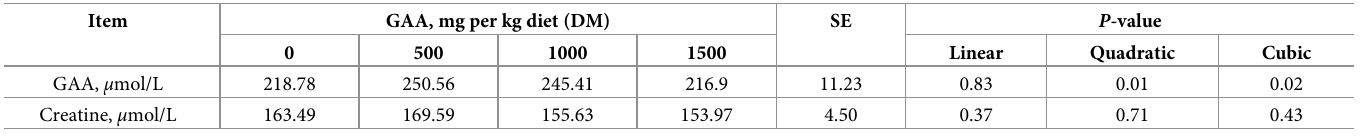
Table 4. GAA and creatine concentration in jugular vein plasma of lambs after feeding 4 h. Item